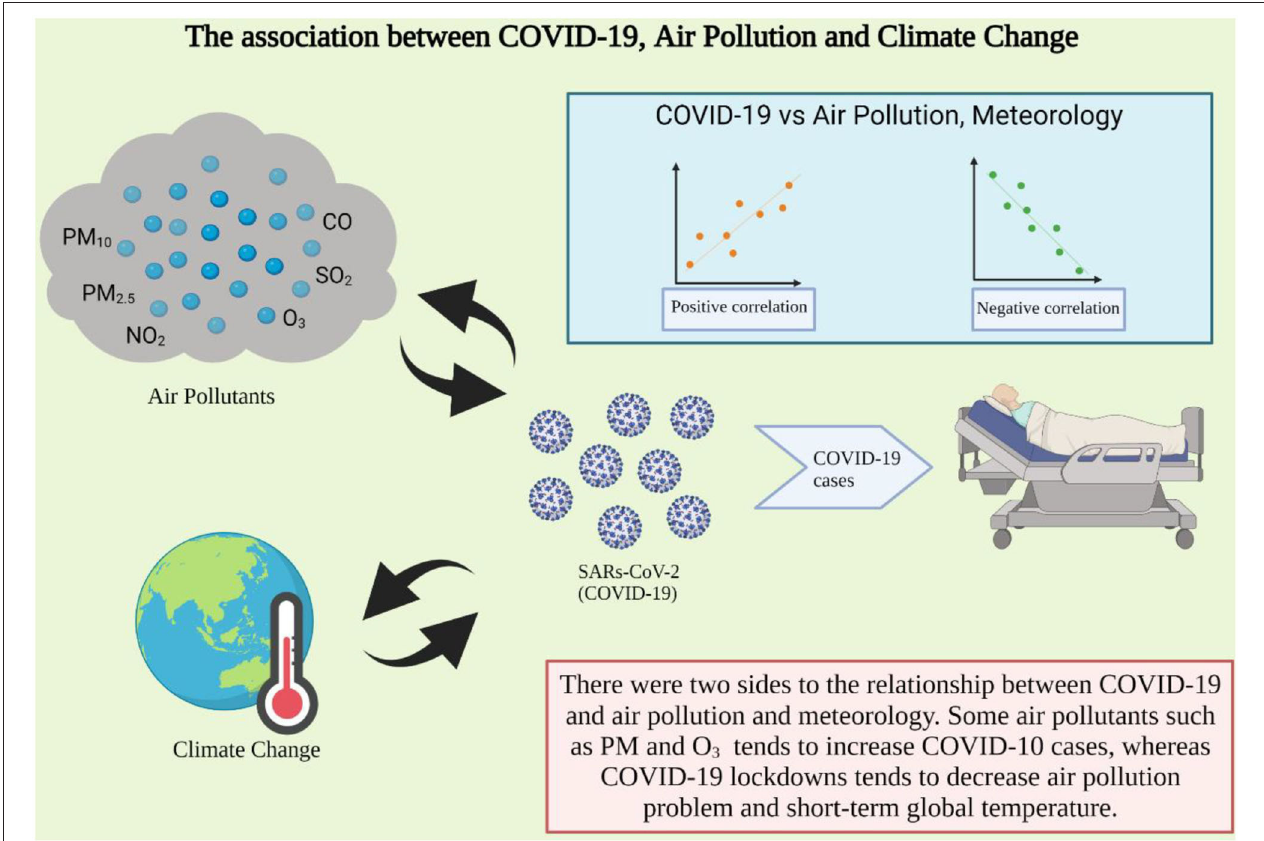
FIGURE 1 | The association between COVID-19 and air pollution and climate change (Created with BioRender.com).